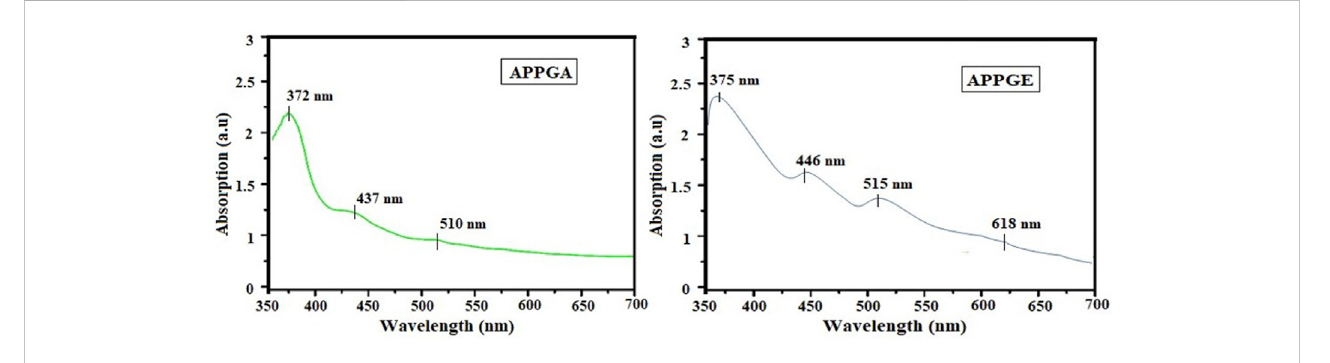
UV-Vis spectroscopy of the APPG leaf extract with acetone and